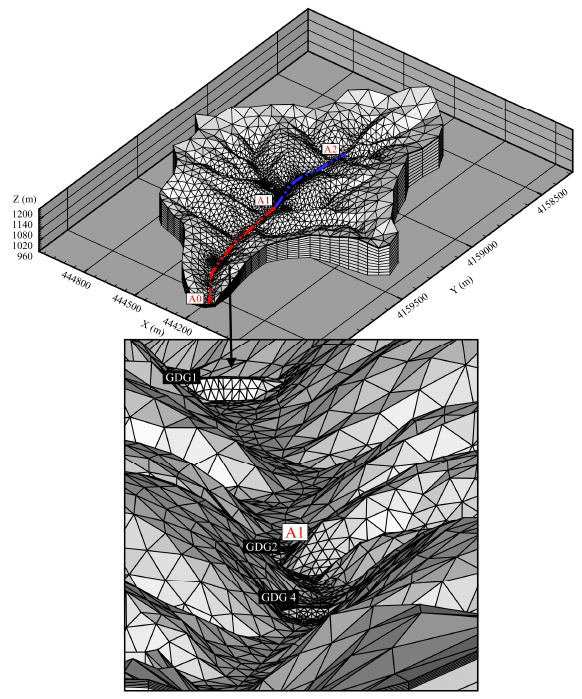
Figure 3. 3D mesh for EDS scenario, the inset is a downstream view from position A2.